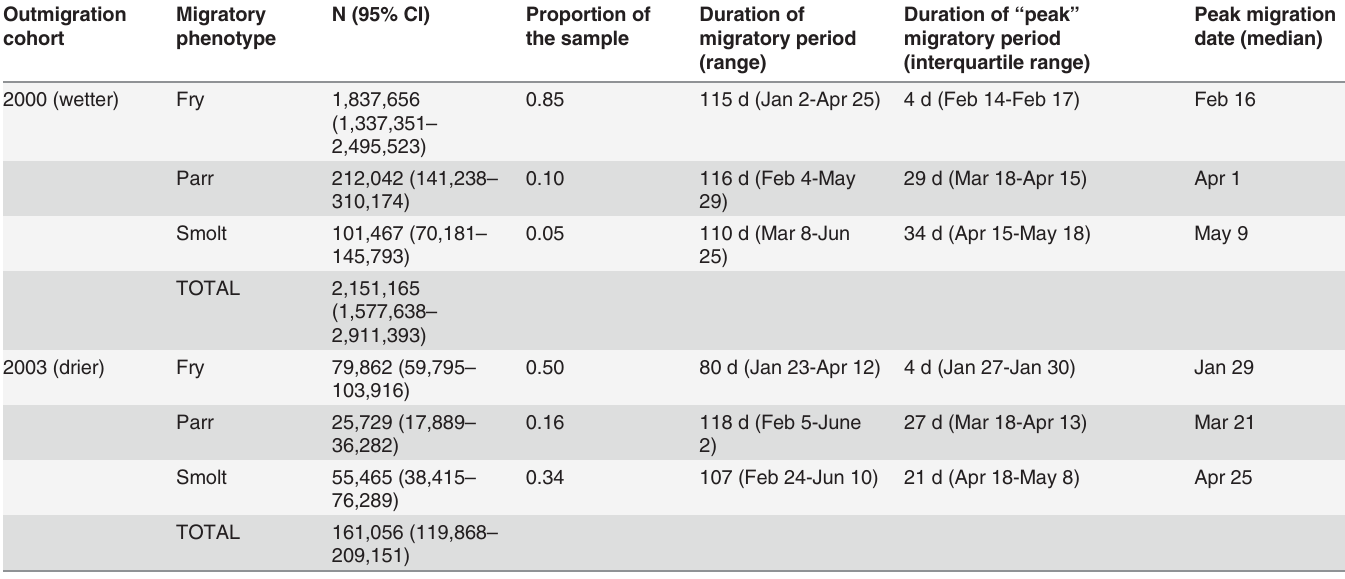
Table 2. Abundance and migration timing of juvenile migratory phenotypes.